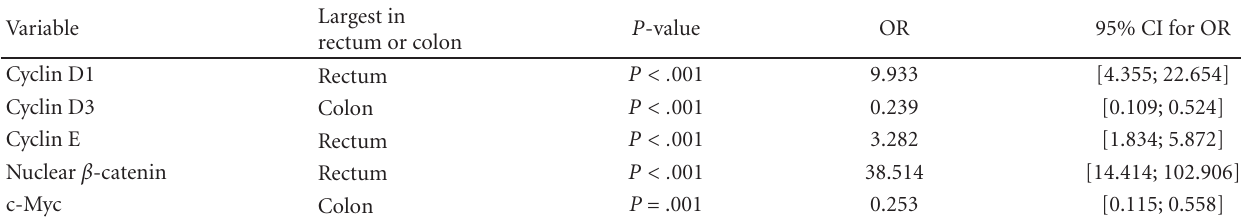
Table 4: Protein expression. Variables that showed a significant di ff erence between rectal cancers and colon cancers (results of binary logistic regression analysis on 400